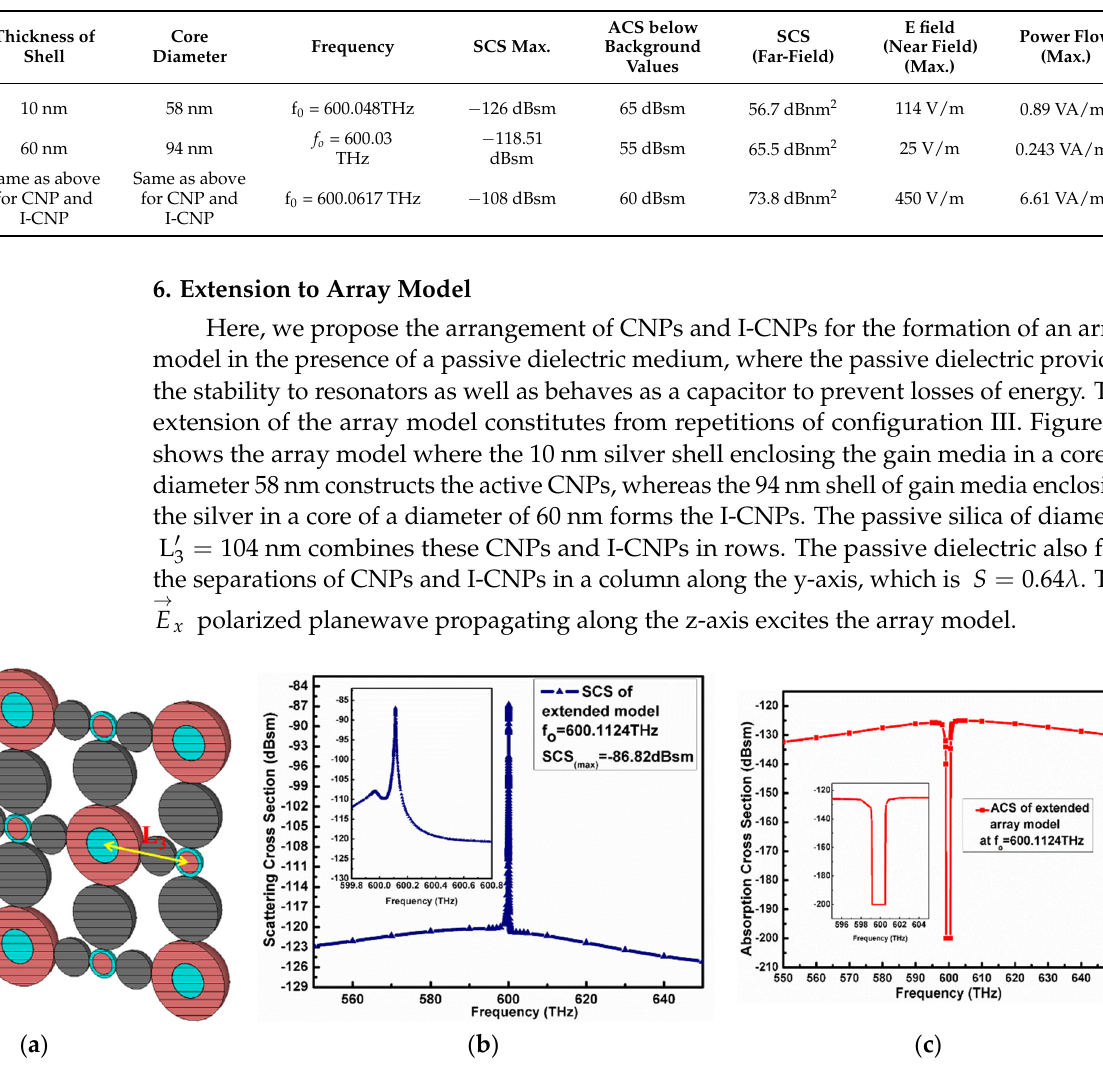
Figure 7. ( a ) Label diagram of extension of array model comprising both CNPs and I-CNPs; ( b ) scattering cross-section; ( c ) ACS of extended array model.